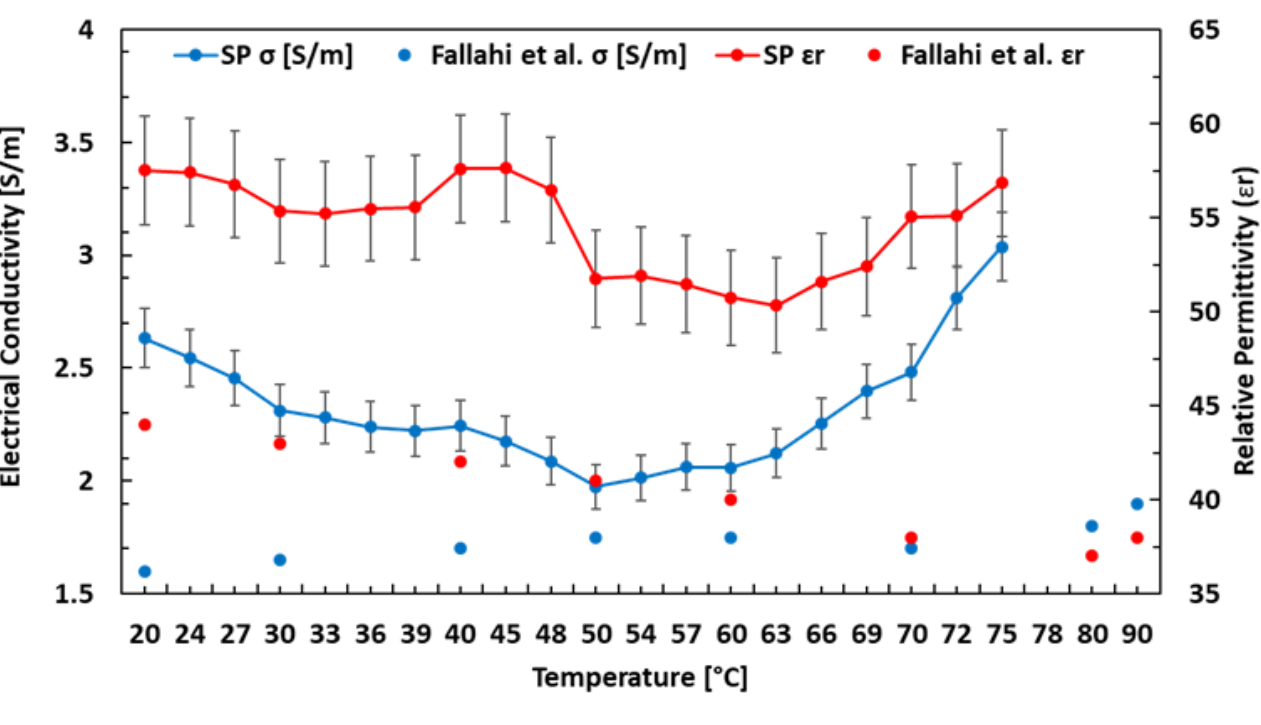
Figure A1. Change in electrical conductivity and dielectric constant of SP and liver with temperature at 2.45